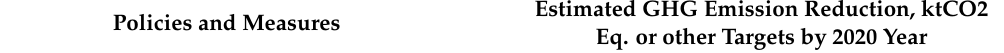
Table 8. Expected impact of policy measures on GHG emission reduction in the Bulgarian energy sector by 2020. Source: